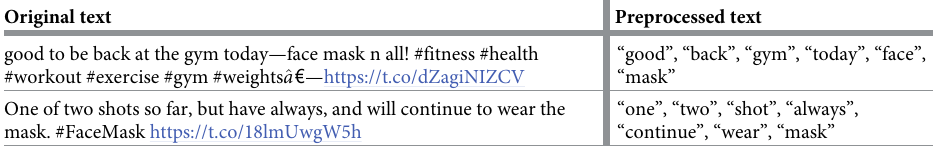
Table 2. Sample tweets text before and after preprocessing